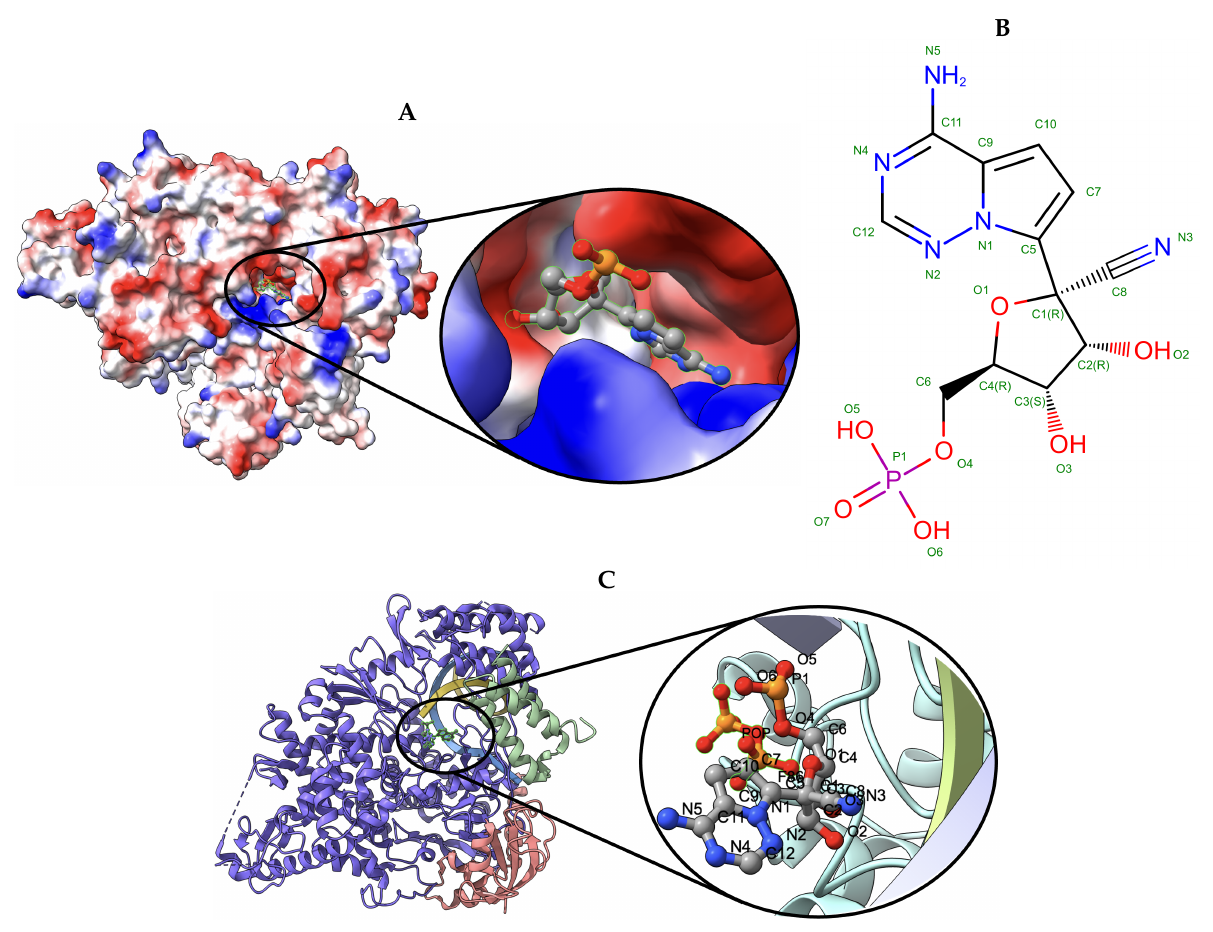
Figure 7. Target 202. ( A ) T0202EM0004_1 (ours) docked by Target 202 (EMD-30210) and visualized with electrostatic potential surface generated in UCSF Chimera. ( B ) Ligand F86, image extracted from Protein Data Bank (PDB). ( C ) Protein–ligand interactions in T0202EM004_1 (ours) model. Chains are colored differently (chain A: blue, chain B: orange, chain C: green, chain P: yellow, and chain T: teal). The ligand is labeled with its atom names as well as the ligand name